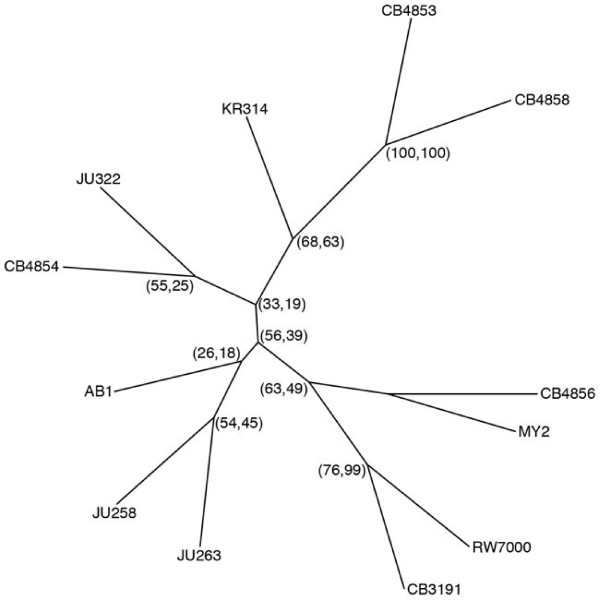
Unrooted consensus tree for 12 natural isolates of C. elegans. The two numbers listed in parentheses next to each node are the percentage of trees among 1000 bootstrap replicates that included all strains distal from CB4856, under Camin-Sokal and Wagner parsimony, respectively. The tree should not be interpreted strictly as a phylogeny due to recombination between strains.